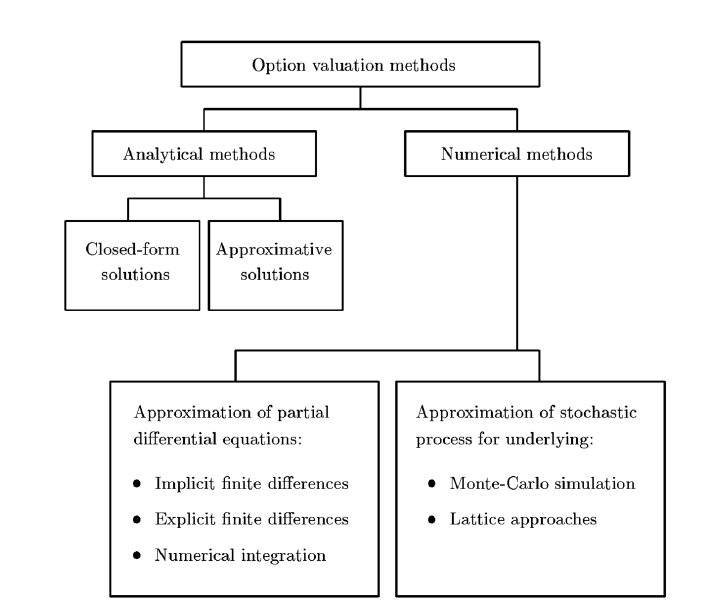
Figure 6. Classification of real option valuation (ROV)